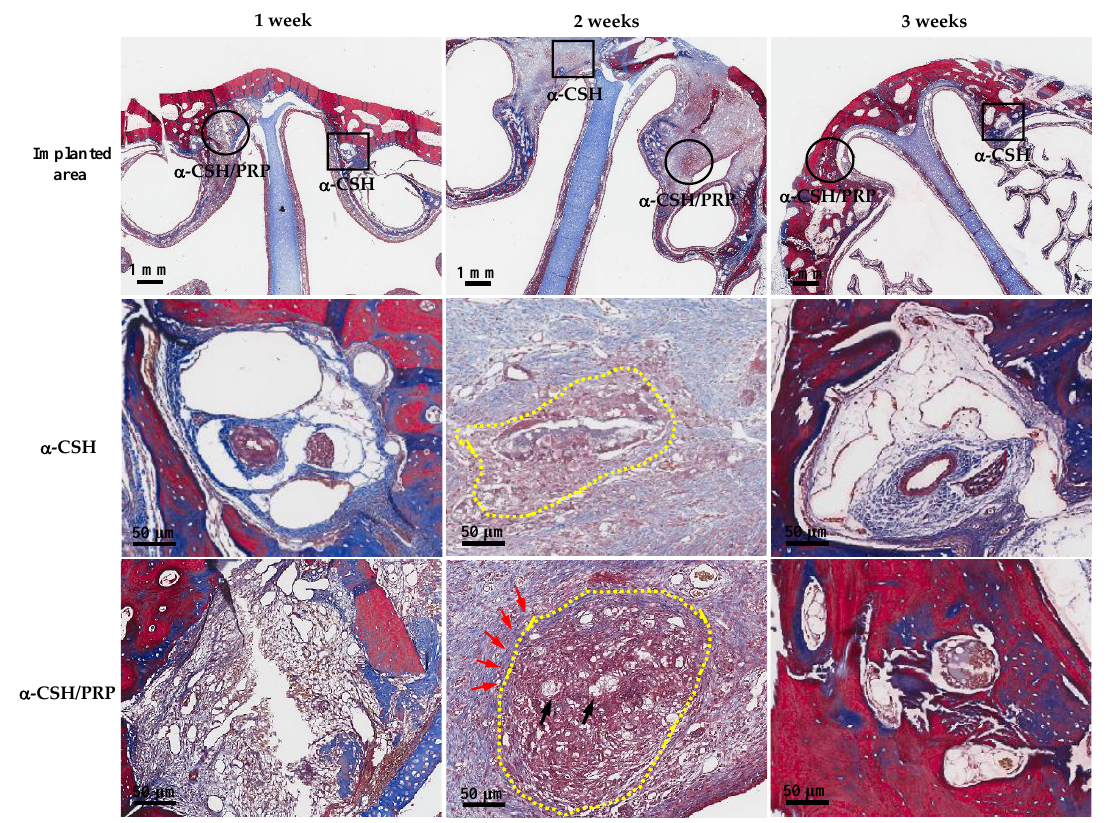
Figure 5. Masson trichrome staining results of α-CSH and α-CSH/PRP at 1, 2, and 3 weeks after implantation. (The higher magnification images were taken from the investigated samples in each time point marked as black circular and rectangular areas,